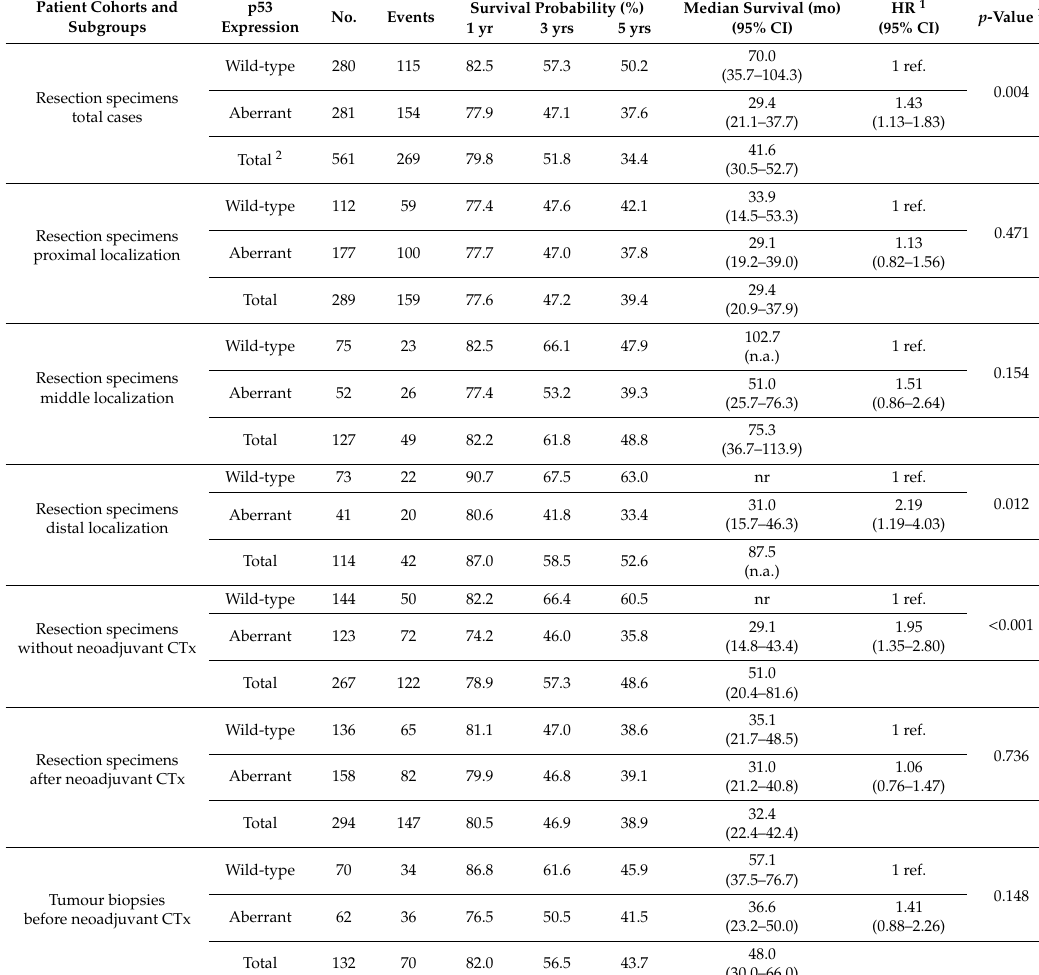
Table 2. Survival data of the patient cohorts and subgroups in association with the p53 expression. Patient Cohorts and